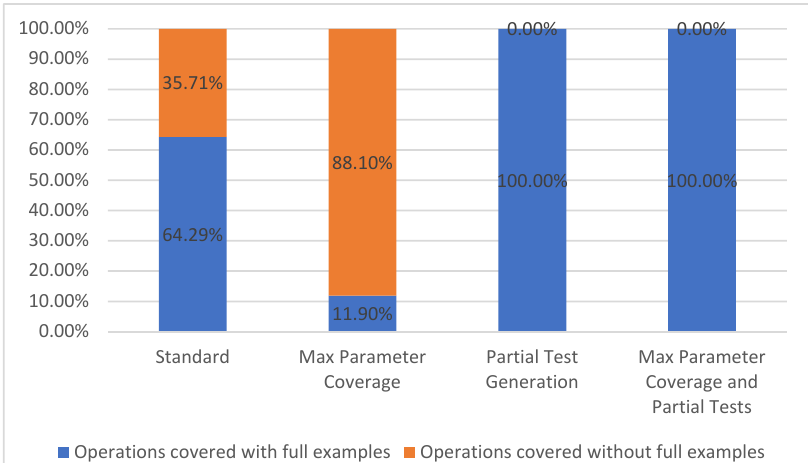
Figure 8. Operation coverage.